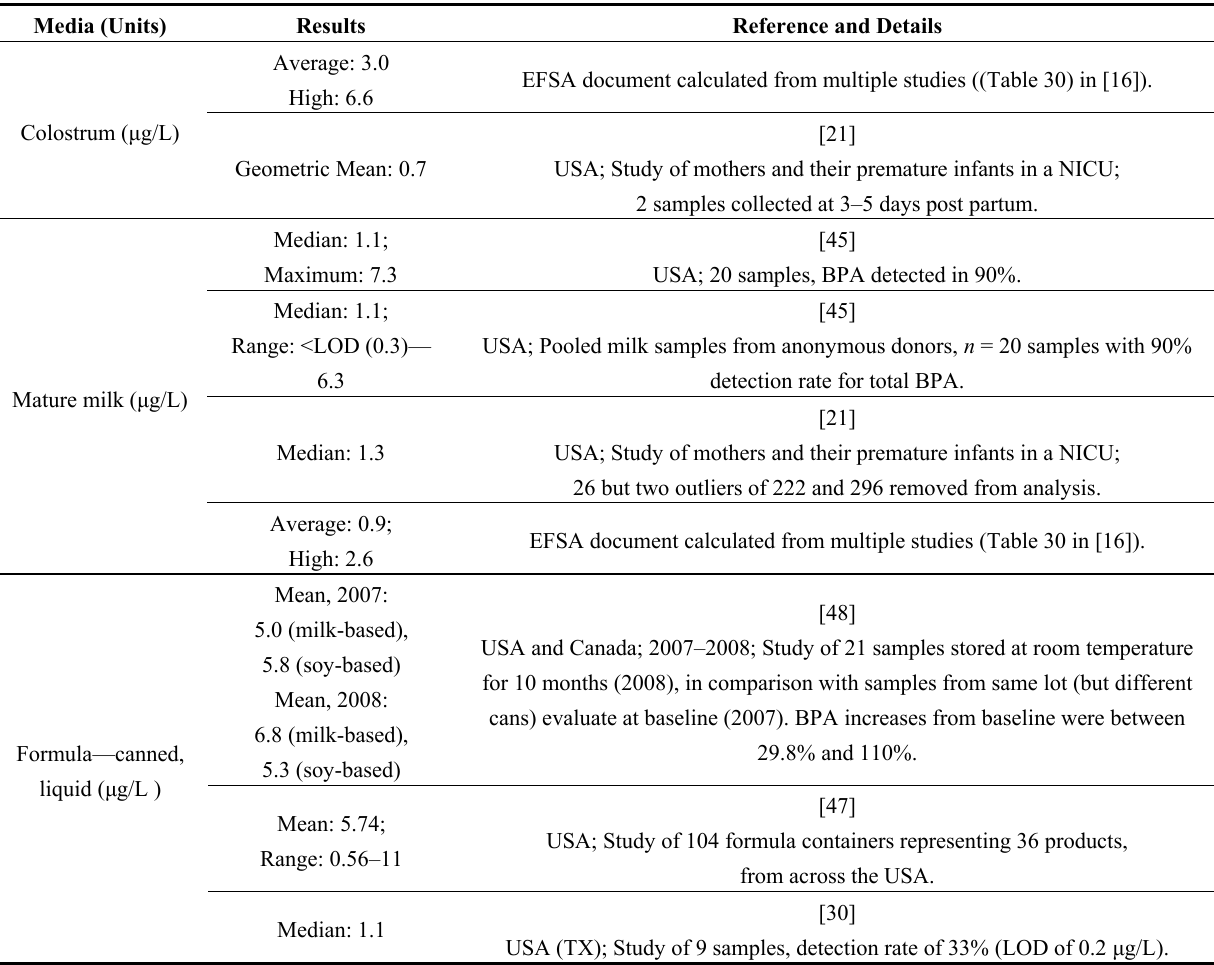
Table A8. BPA concentrations in breast milk, colostrum and